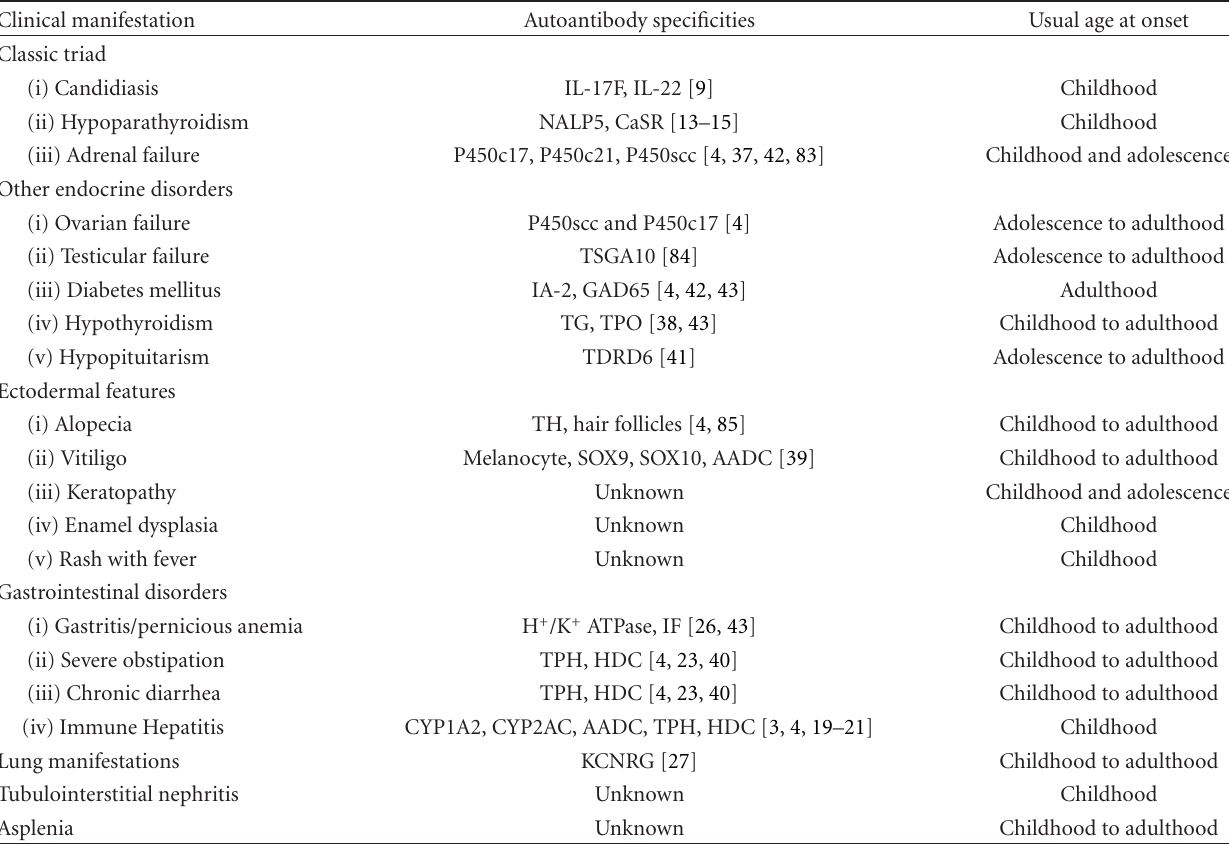
Table 1: Main clinical features of APECED, specific related autoantibodies (when clearly associated with clinical manifestation) and usual period of life at onset of disease.